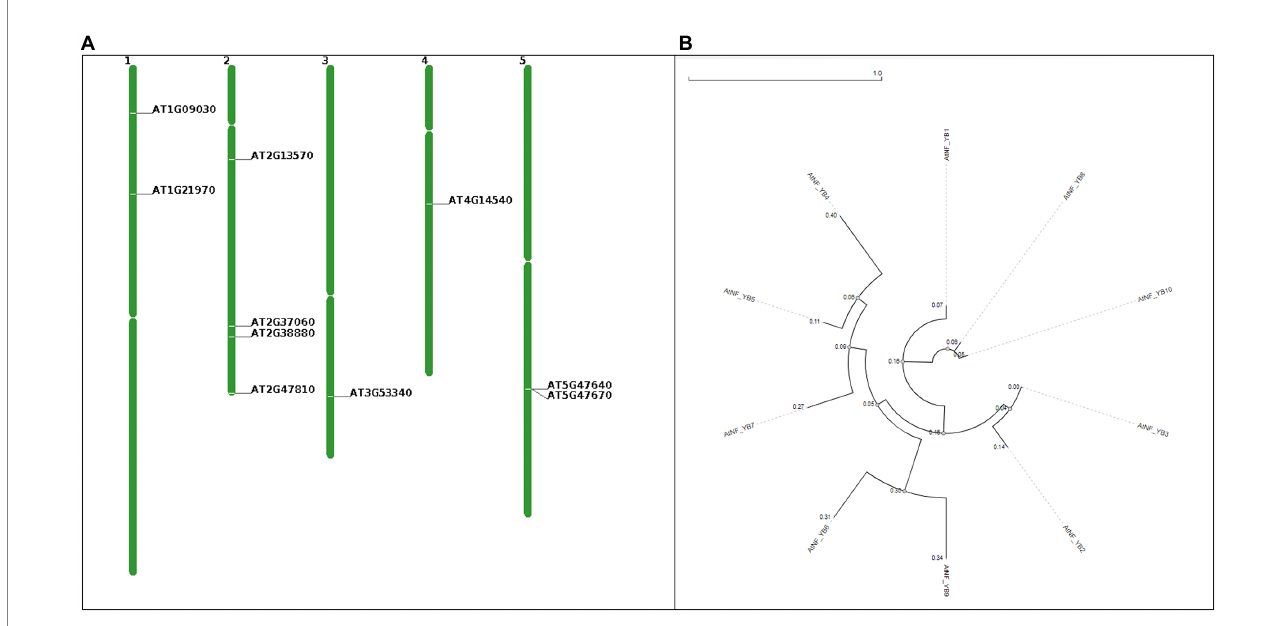
FIGURE 1 (A) Chromosome map tools generated visual depiction indicating positions of AtNF-YB1 to AtNF-YB10, in the Arabidopsis thaliana chromosomes. Locus tags in the image are represented as AT2G38880 (AtNF-YB1), AT5G47640 (AtNF-YB2), AT4G14540 (AtNF-YB3), AT1G09030 (AtNF-YB4), AT2G47810 (AtNF- YB5), AT5G47670 (AtNF-YB6), AT2G13570 (AtNF-YB7), AT2G37060 (AtNF-YB8), AT1G21970 (AtNF-YB9) and AT3G53340 (AtNF-YB10). (B) Phylogenetic circular tree of AtNF-YB family members constructed using NGPhylogeny.fr and visualised using Phylogenetic tReE viSualisaTiOn (PRESTO) using the maximum likelihood method, using the FastME workflow in automatic default parameters. All 10 protein sequences were extracted from